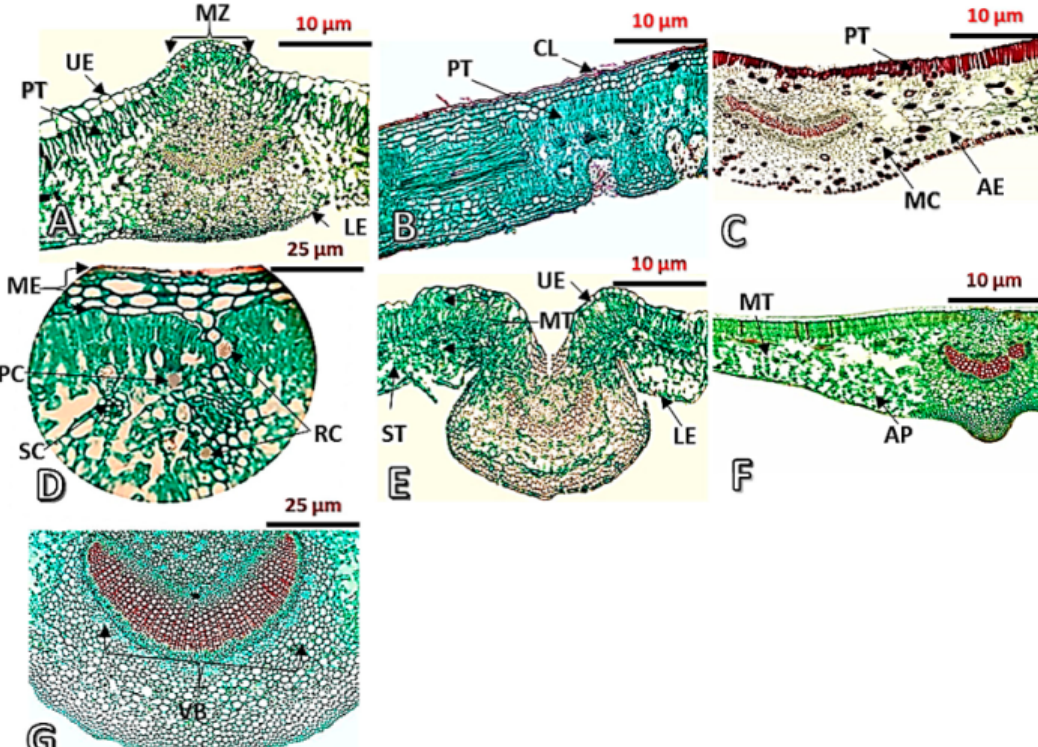
Figure 4. Transverse sections in the leaves of the studied Apocynaceous species taken by light microscope. ( A ): D. boliviensis (70 × ), ( B ): N. oleander (70 × ), ( C ): C. carandas (70 × ), ( D ): N. oleander (140 × ), ( E ): A. curassavica (70 × ), ( F ): T. neriifolia (70 × ), ( G ): N. oleander (70 × ). AE = aerenchyma tissue, AP =